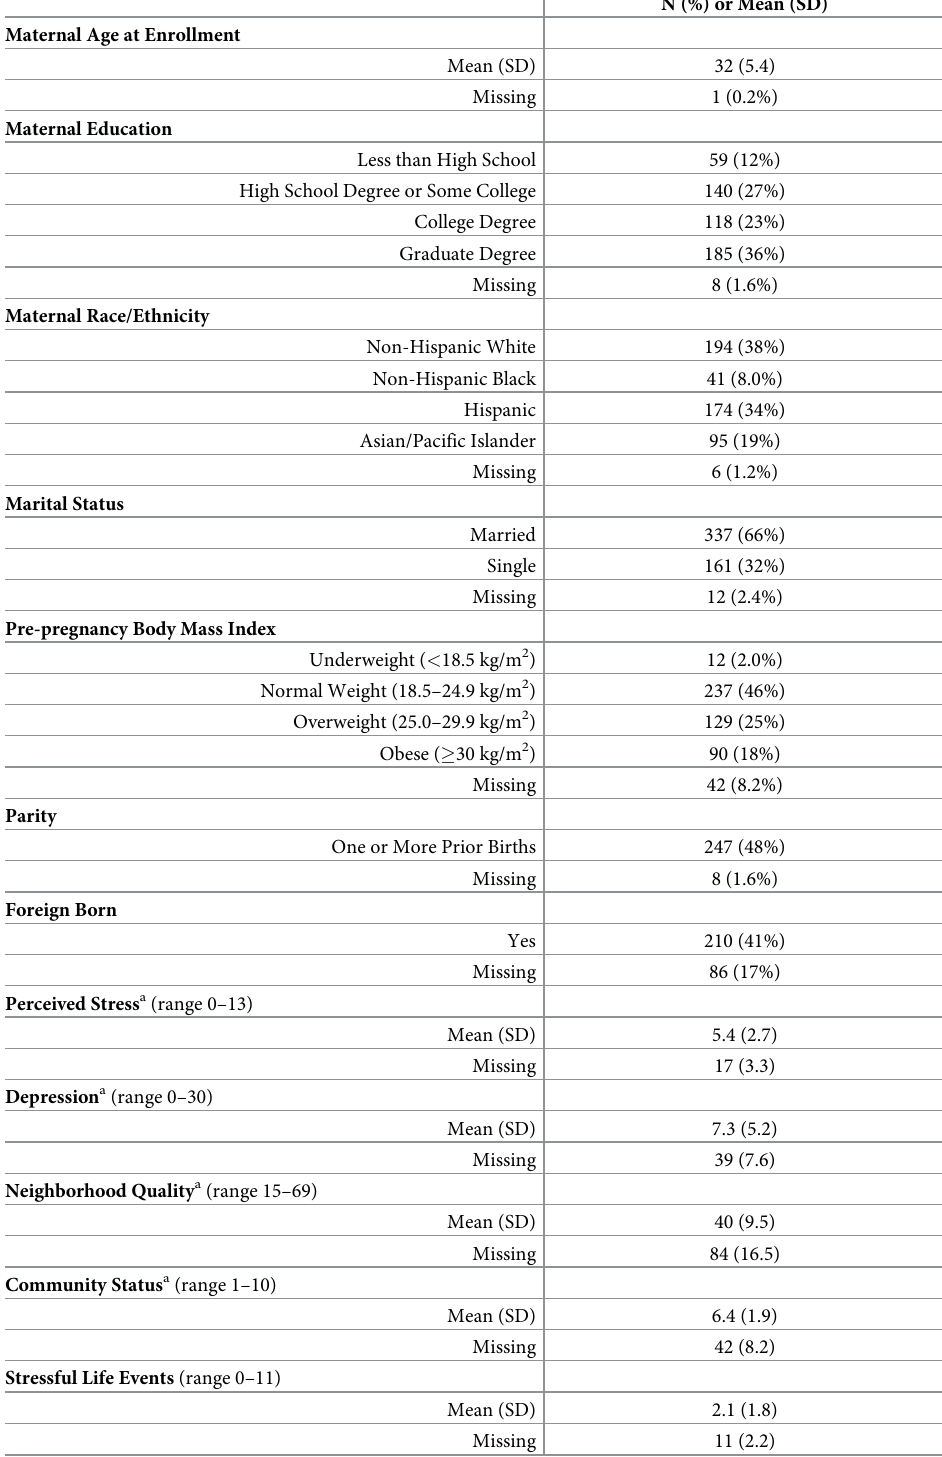
Table 1. Distribution of demographic characteristics and psychosocial stress measures and responses to stress in the Chemicals in Our Bodies cohort (N =